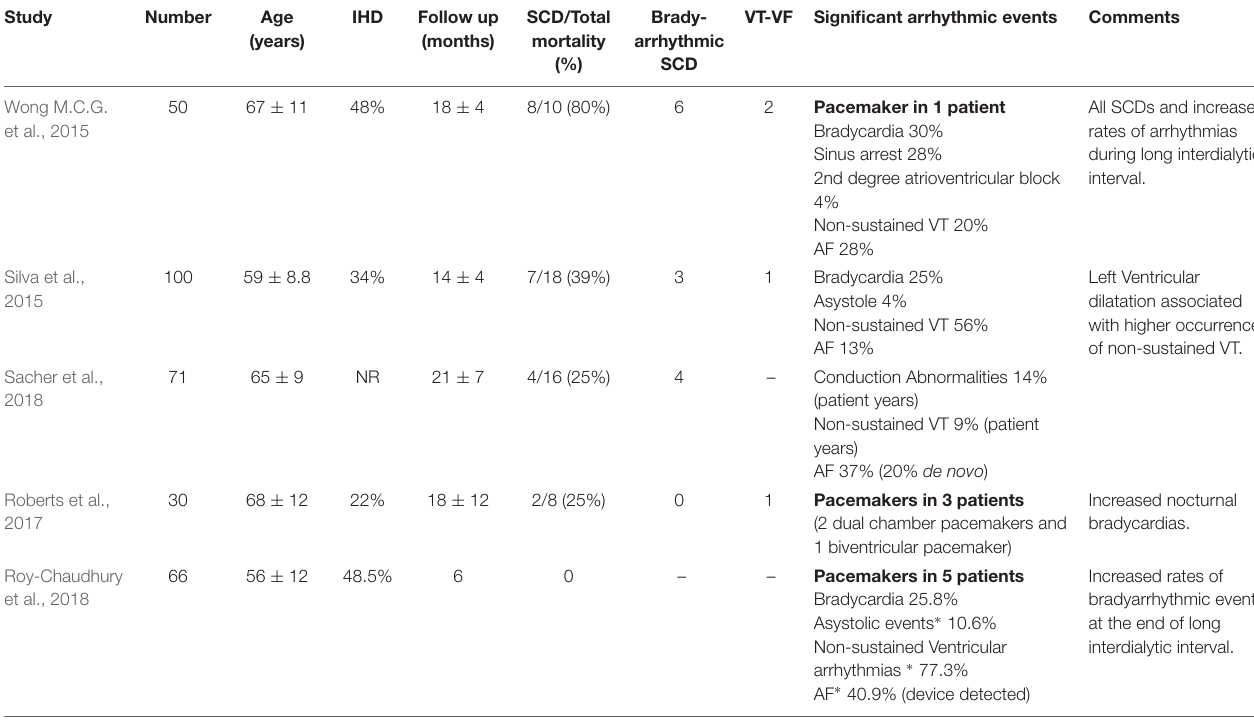
TABLE 1 | Studies using implantable loop recorders in HD